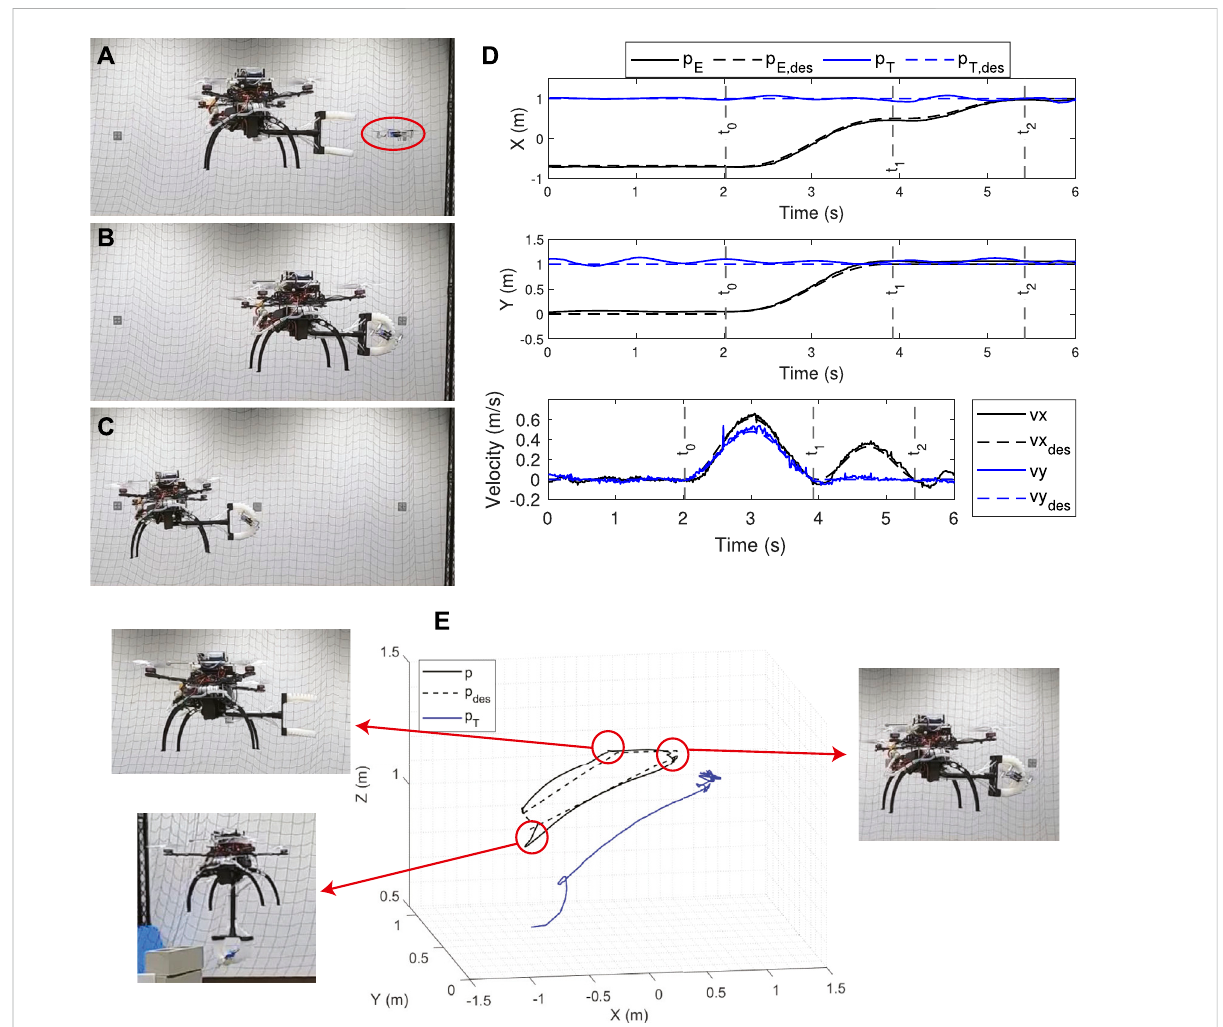
FIGURE 7 A sample trial of the static catching test. (A – C) The SoAG robot approaches the target, grasps the target, and returns with the target. (D) State tracking for the end-effector and target. (E) 3D positions of the SoAG robot and the target aerial